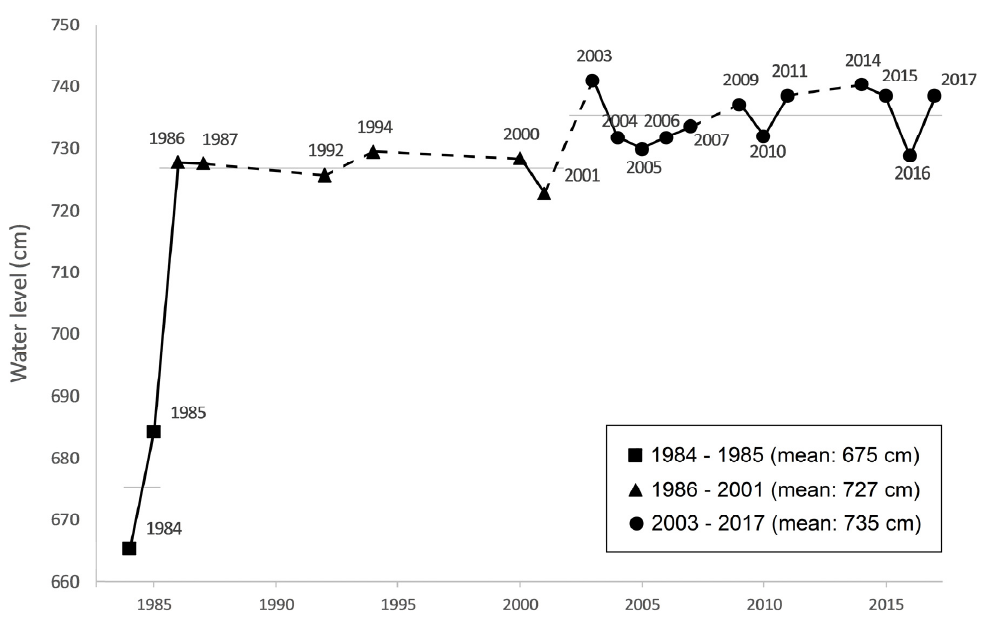
Figure 2. Mean water levels for July each year between 1984 and 2017. (The water level zero points reported here were collected at ‘Kisköre fels ő ’ at 81.32 meters above sea level.).